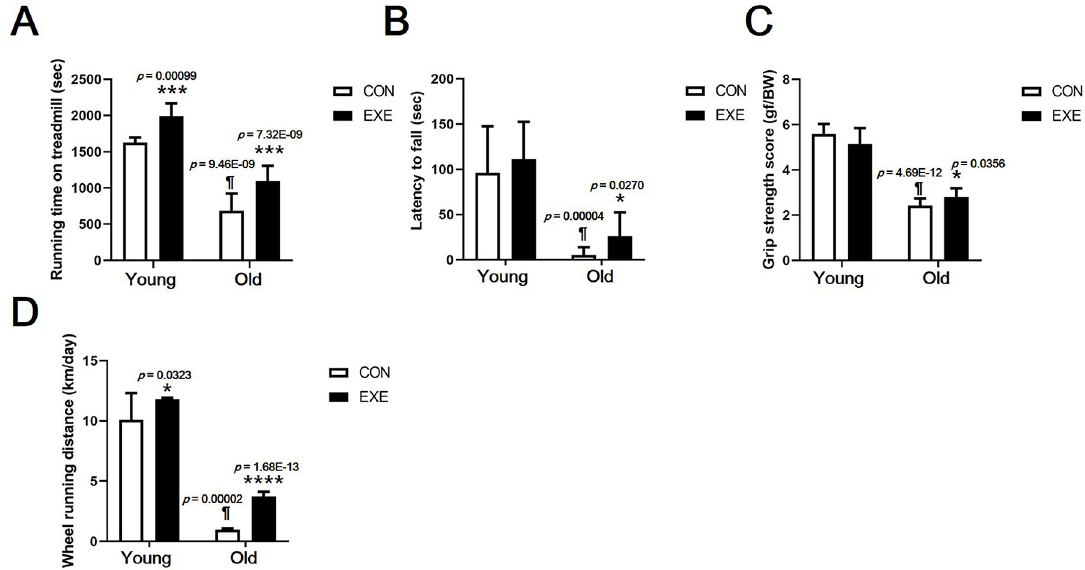
Fig 1. Lifelong spontaneous exercise (LSE) delays the decline in physical fitness attributed to aging. (A) Endurance test. (B) Rotarod test. (C) Grip strength test. (D) Habitual spontaneous exercise test. All data are presented as the mean ± standard deviation (SD); vs. control group of same age, � p < 0.05 and ��� p < 0.001; vs. control group of different age, ¶ p < 0.0001. Partially modified from Fig 3 of a previous study